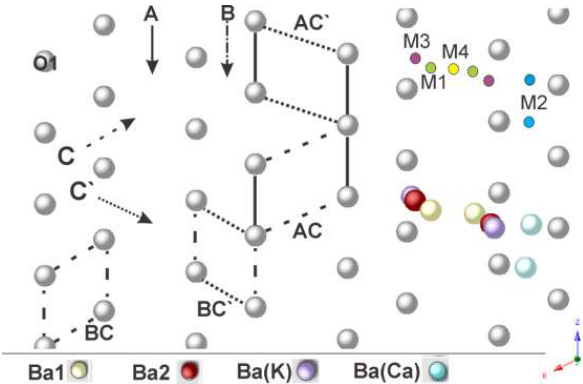
Figure 6. Gallery representation of the structure of Ba-clinoptilolite: distribution of O1 atoms in the plane 020, with directions of lanes A, B, C, and C` and location of the extra-framework cation positions and Ba positions.